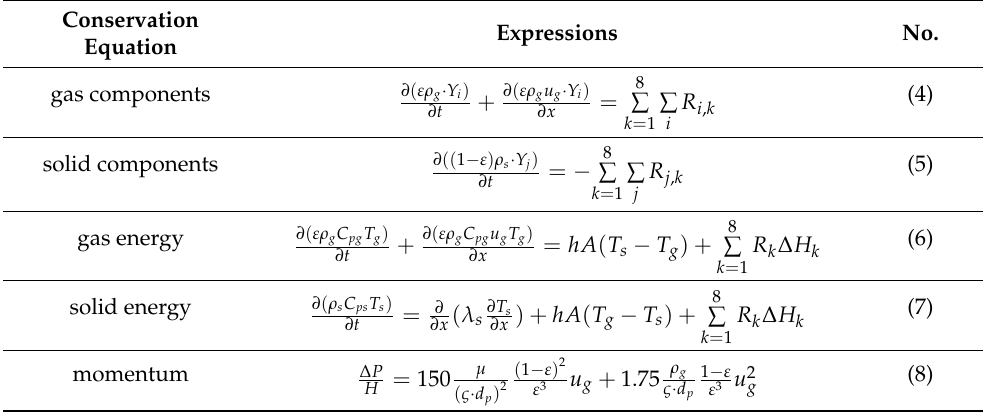
Table 1. Summary of the control equations of the numerical